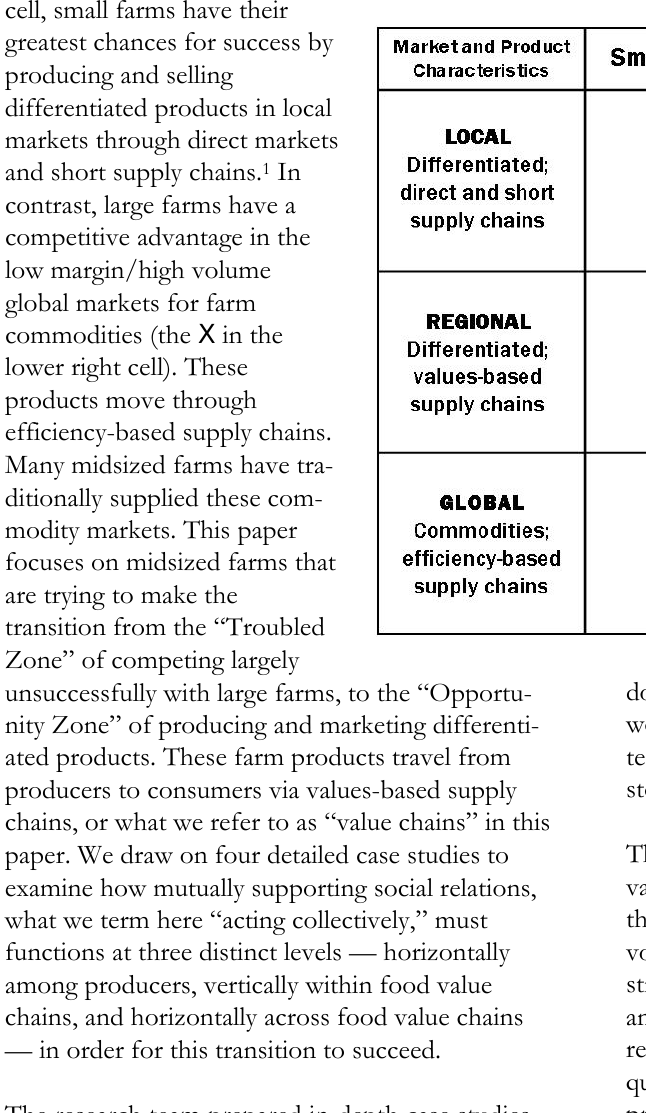
Figure 1. Farm Size Shapes Market